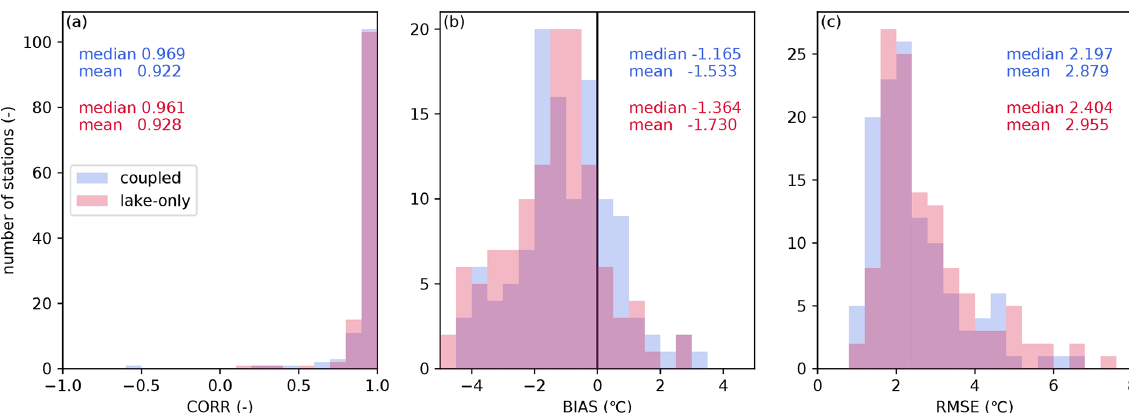
Figure 10. Comparison of reproducibility indices for lake surface temperature. Bars indicate the histogram of each index, and written values show the media and mean values: blue and red indicate the result of the coupled and lake-only simulations, respectively. Panel (a) shows CORR (–), panel (b) shows BIAS ( ◦ C), and panel (c) shows RMSE ( ◦ C).